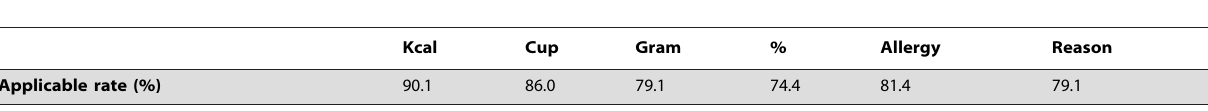
Table 5. Applicable rate of the respective